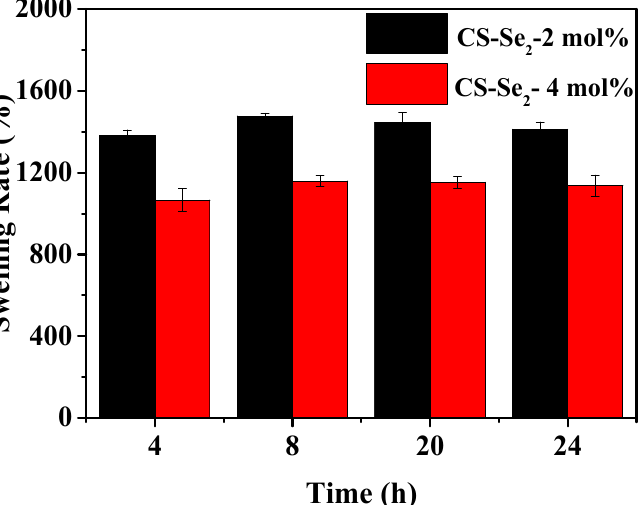
Figure 4. The swelling behavior of the 2 and 4 mol% Se-containing chitosan hydrogels soaked in PBS buffer (pH = 7.4) for different times. All the experiments were carried out three times using separate samples, and the average values were reported.